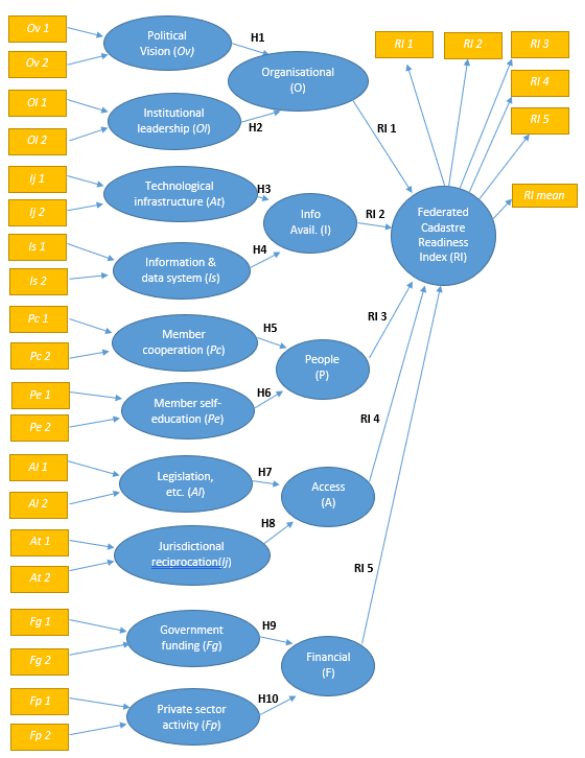
Figure 6 . PLSSEM analysis hypotheses model – initial readiness index